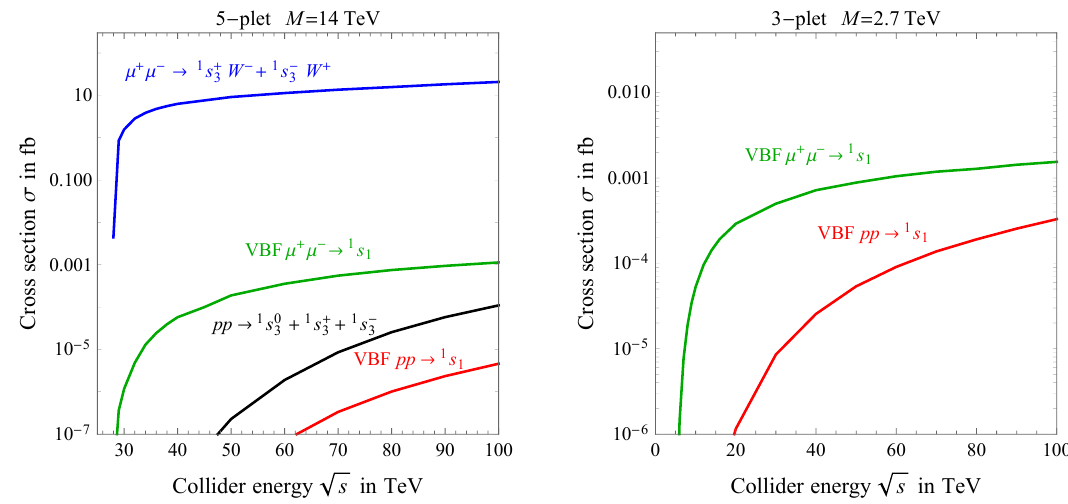
Figure 4. Cross sections for the production of some bound states of the Minimal DM fermionic 5-plet with constituent mass M = 14 TeV (left) and of the fermionic 3-plet with M = 2 . 7 TeV (right) at a µ + µ − collider and at a pp